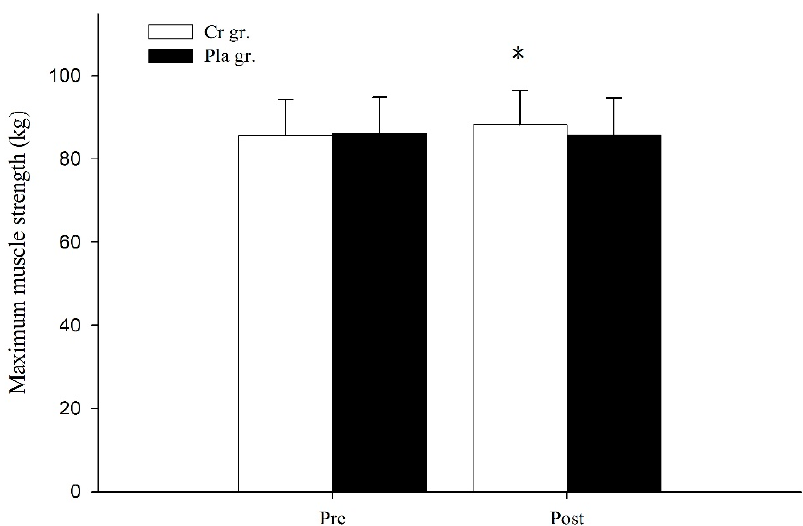
Figure 1. Maximum muscle strength of bench row before and after six days of creatine or placebo supplementation. Data are the means ± standard deviation. Cr gr. = creatine group; Pla gr. = placebo group; Pre = pre-supplementation; Post = post-supplementation. Asterisk (*) indicates a significant difference ( p < 0.05) from the pre-supplementation value within the group.